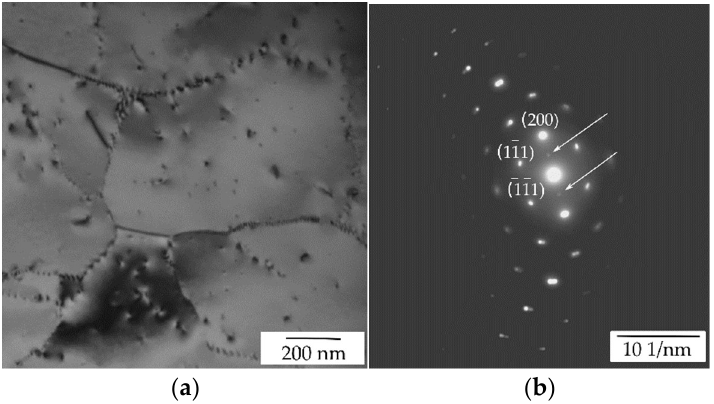
Figure 10. TEM image of the AlMnYbZr AC alloy after isochronal treatment up to 540 °C—see ( a ) secondary Al 3 (YbZr) particles and ( b ) selected area diffraction near [011] Al pole which shows the presence of diffraction spots of the structure L1 2 .